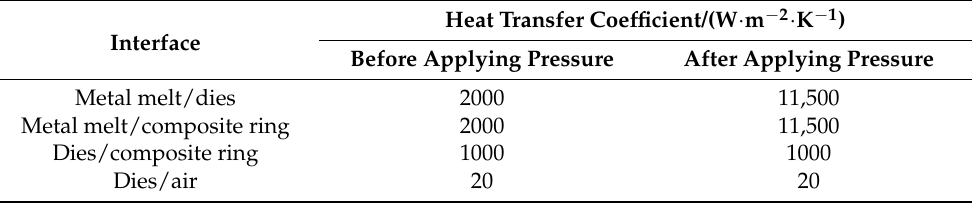
Table 2. Interfacial heat transfer coefficients before and after applying external